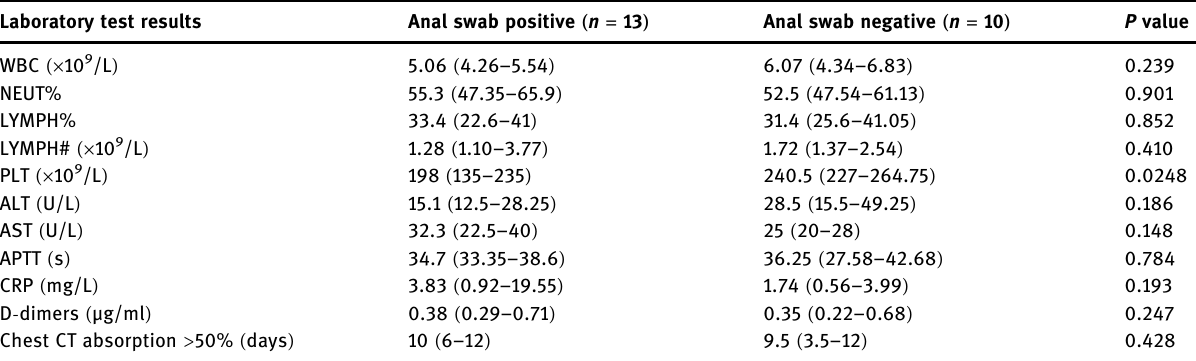
Table 2: Comparison of laboratory results of COVID - 19 patients Laboratory test